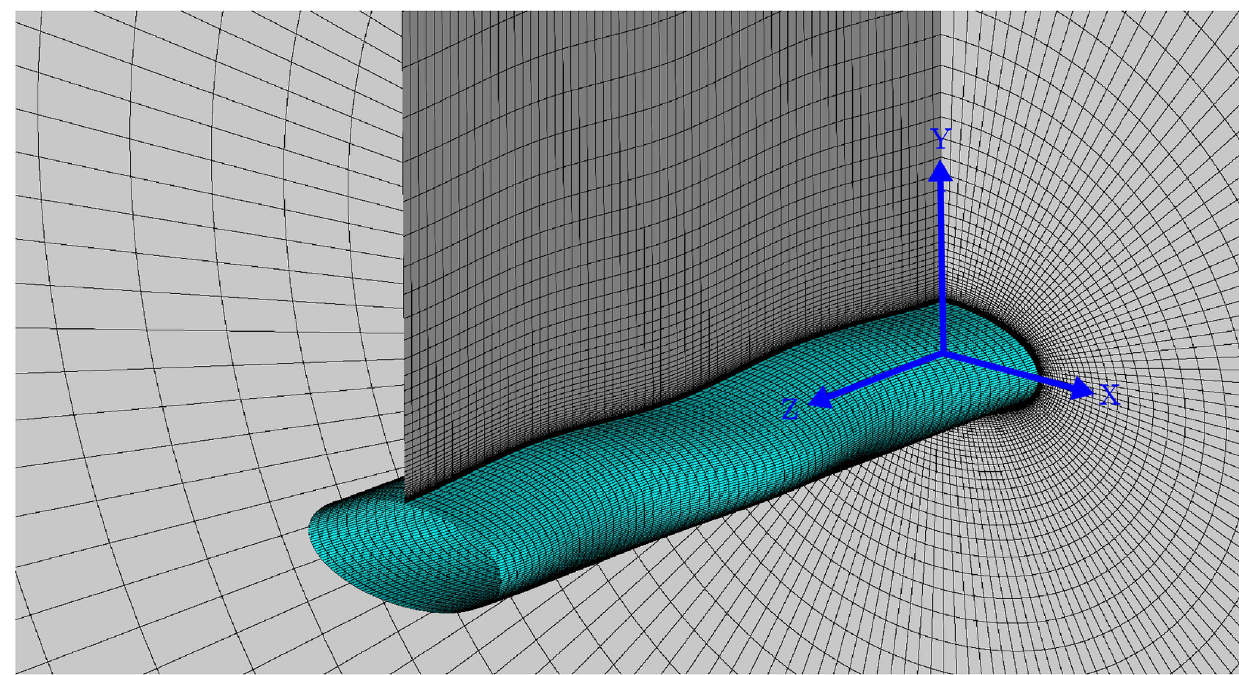
Fig 4. LES mesh for baseline model. Figure shows mesh used for simulation of baseline model using LES at Re details are listed in Table 4.